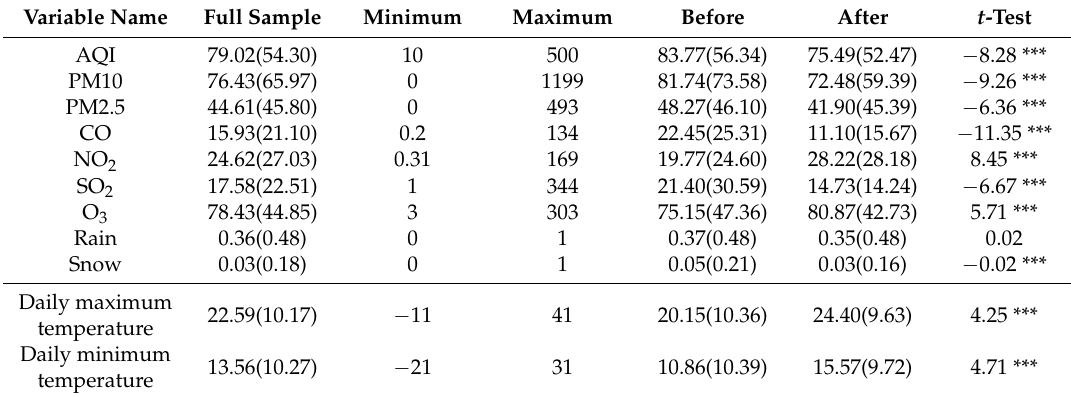
Table A1. Statistical characteristics and comparison of variables before and after the implementation of central environmental protection inspections.